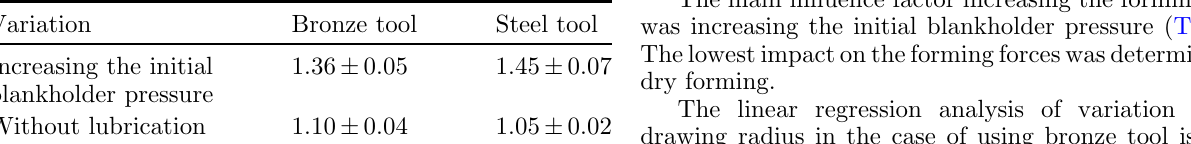
Table 3. Factors for increasing the forming forces in the case of using bronze tool and steel tool.